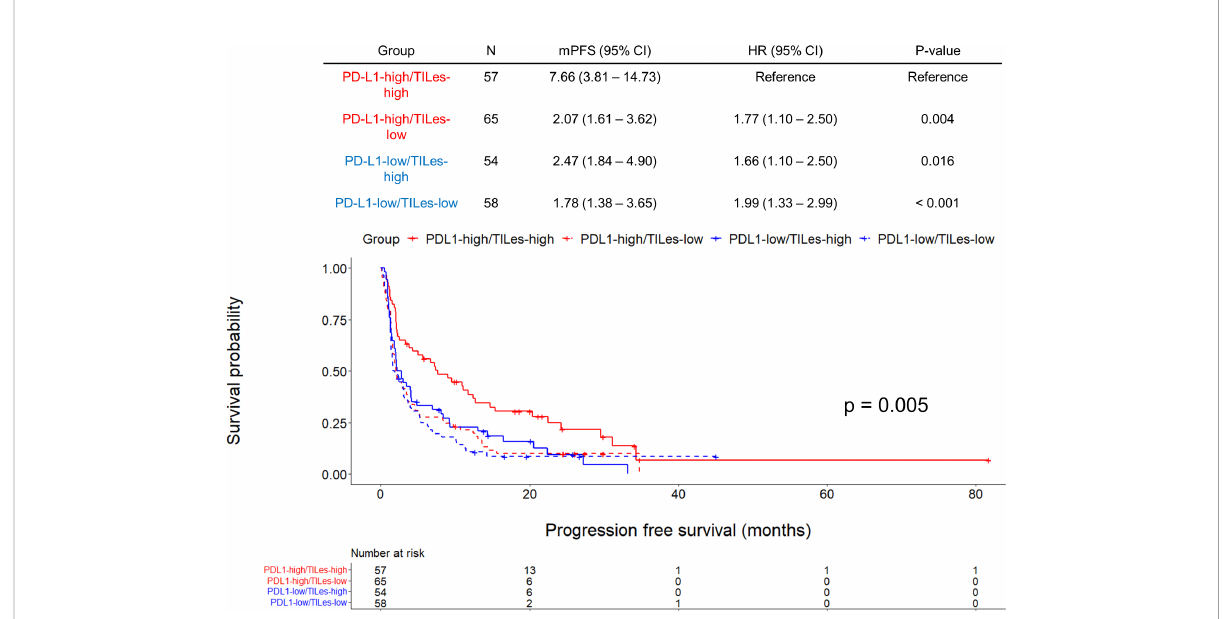
FIGURE 4 Outcomes of ICI according to predicted tumor in fi ltrating lymphocyte enrichment score (TILes) and PD-L1 status in the validation cohort. Kaplan-Meier curves showing progression free survival (PFS) according to predicted TILes group and PD-L1 status. Red lines represent the high PD-L1 group and the blue line represents the low PD-L1 group. The solid lines represent the high TILes group and the dashed lines represent the low TILes group. The censored data are marked with vertical lines. The numbers at risk are provided